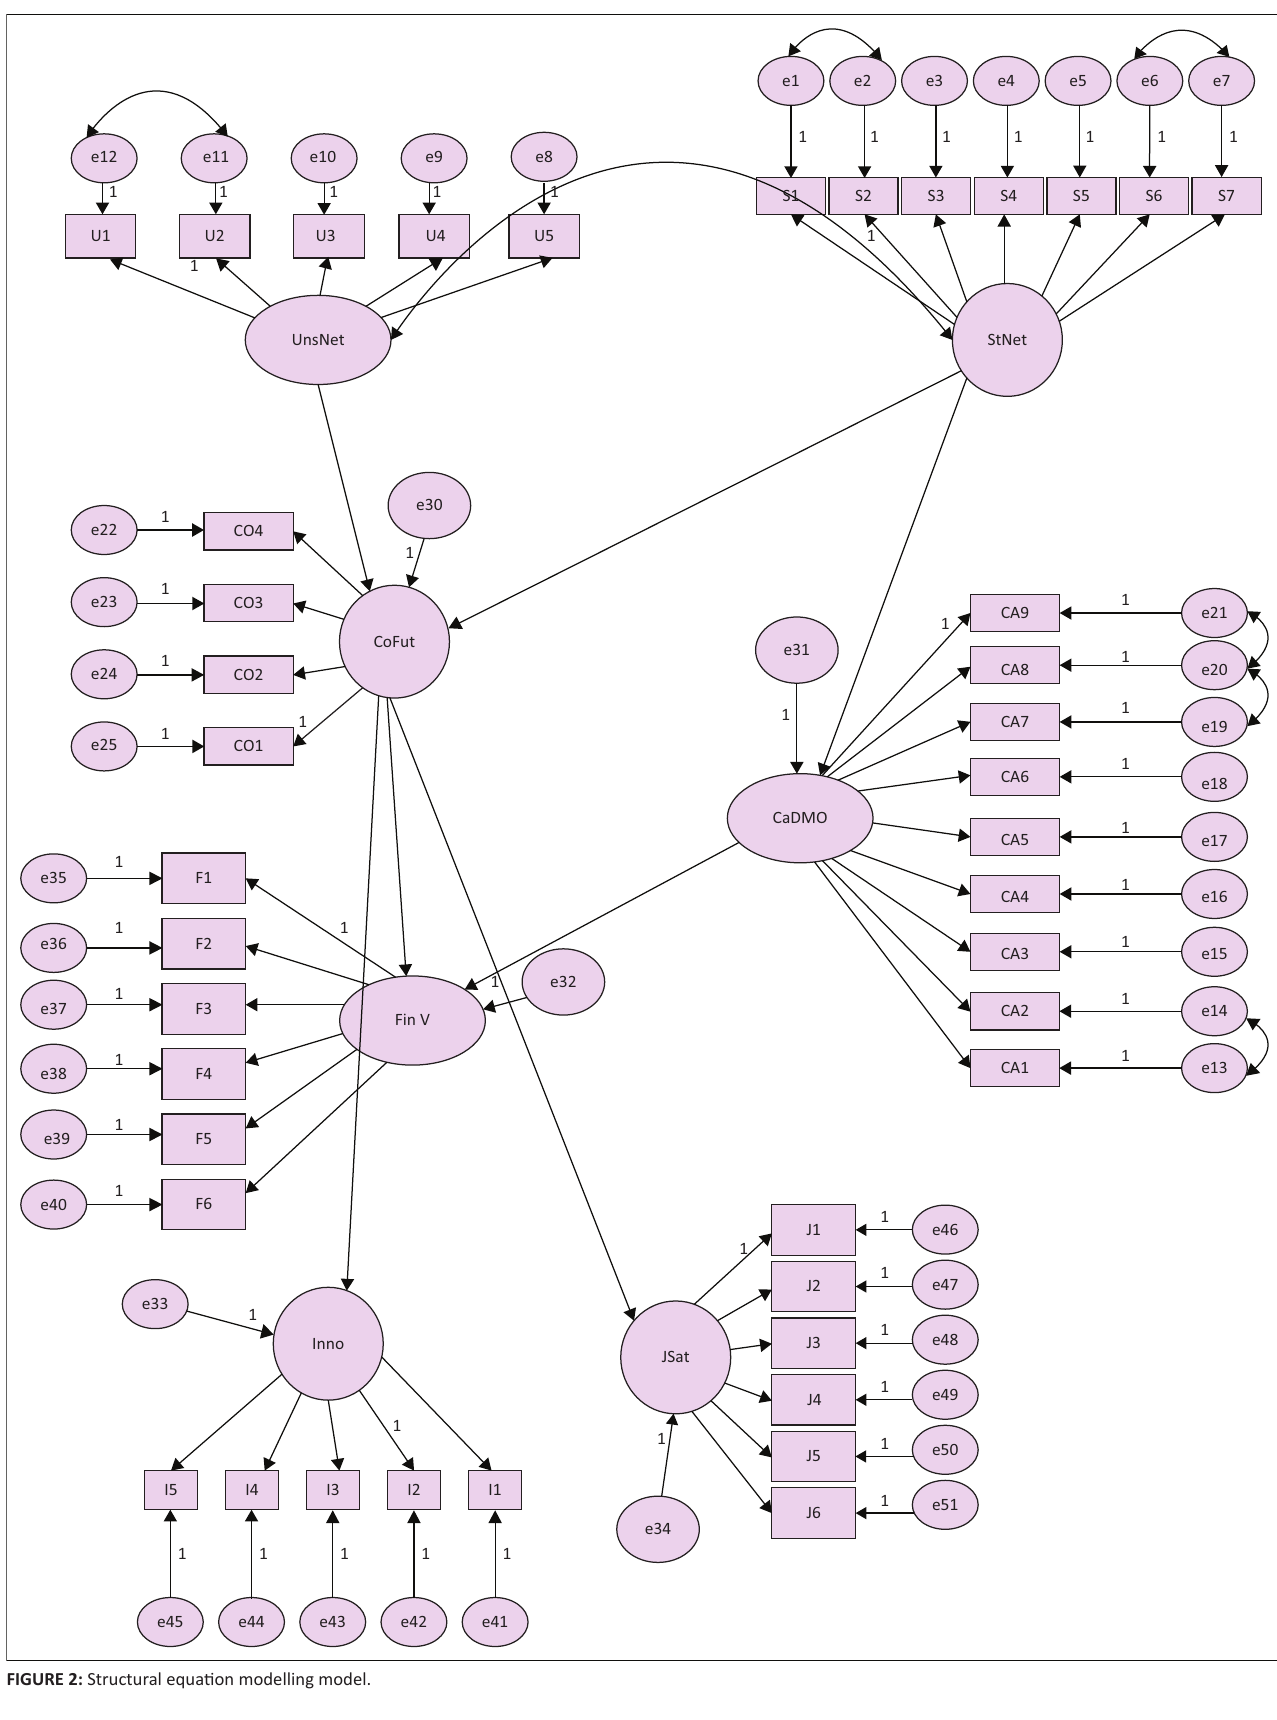
FIGURE 2: Structural equation modelling